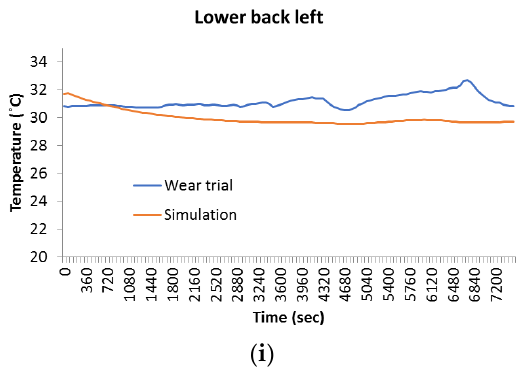
Figure 7. Comparison of skin temperature at different places of the body during wear trial and simulation.